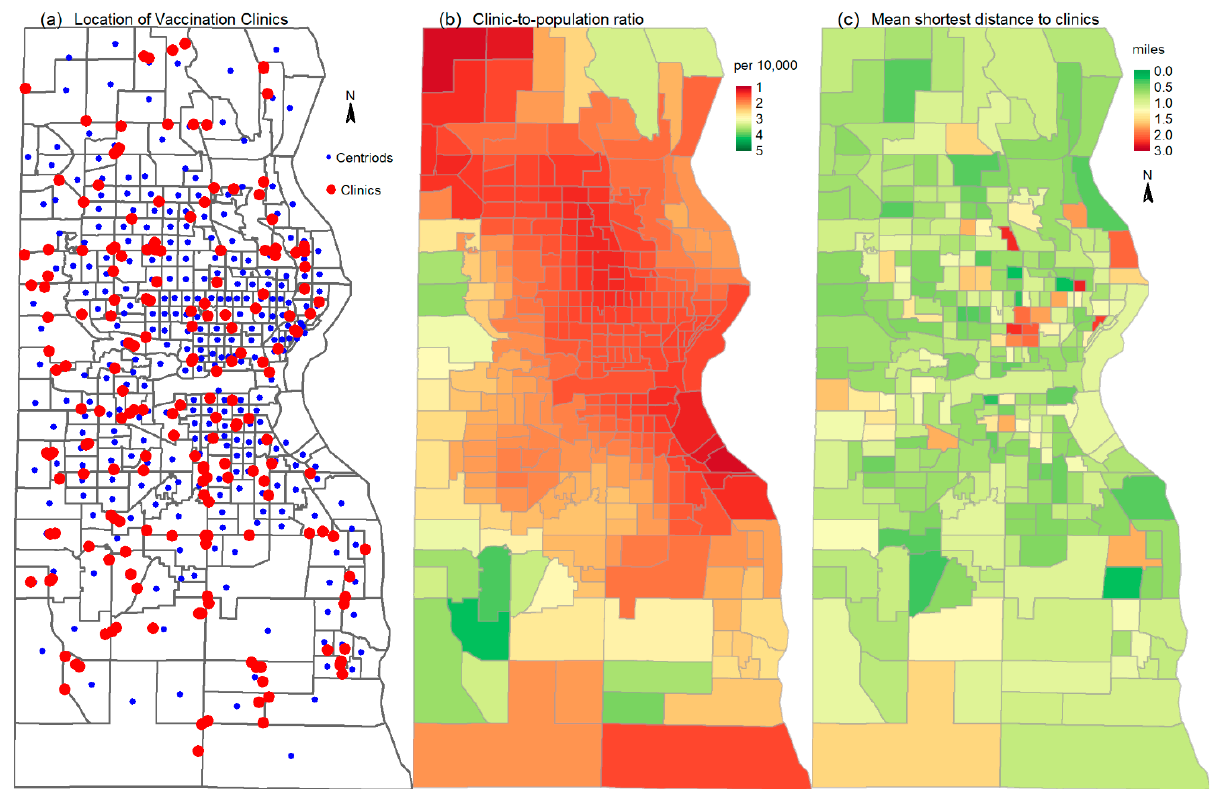
Figure 5. ( a ) Spatial location of the vaccination clinics, ( b ) tract-level clinic-to-population ratio, and ( c ) tract-level mean shortest travel distance to three nearest clinics. ( c ) tract-level mean shortest travel distance to three nearest